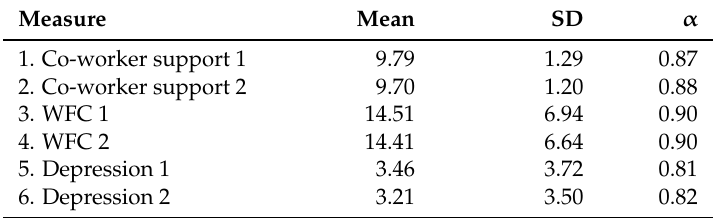
Table 1. Means, standard deviations (SD) and Cronbach’s alpha ( α ) for Australian employees.